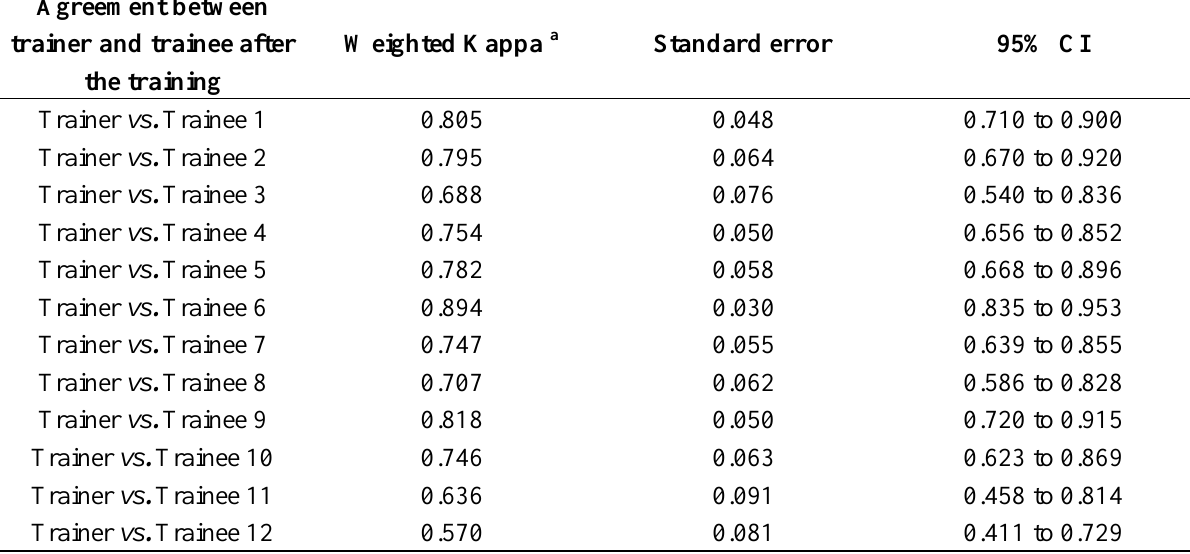
Table 2. The inter-examiner weighted kappa statistics (expert versus trainee/staff member). Agreement